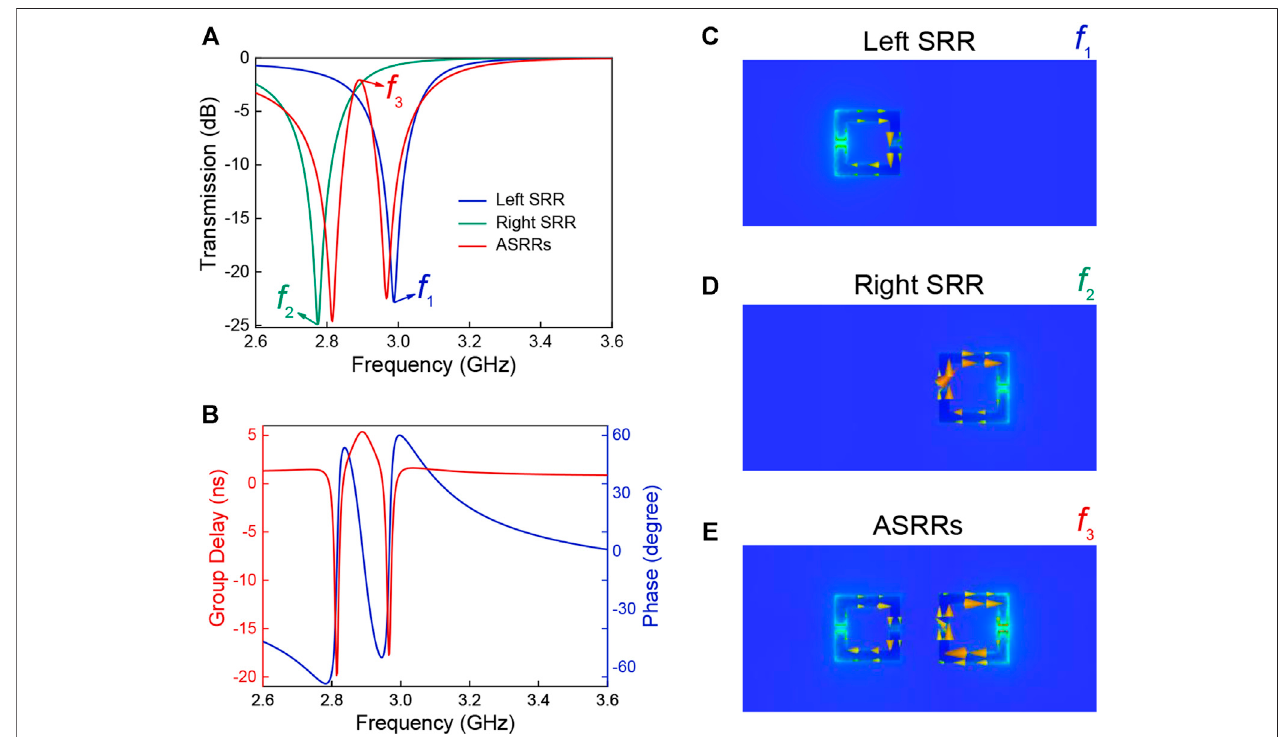
FIGURE 2 | (A) Calculated transmission spectra of the left SRR only (blue curve), right SRR only (green curve), and the asymmetric SRR pair (red curve). (B) Calculated transmission group delay (red curve) and phase (blue curve) of the metasurface. (C – E) Instantaneous distributions of the out-of-plane electric fi eld and the inducedsurfacecurrentcorrespondingtotheresonantfrequenciesat f 1 , f 2 ,and f 3 insection (A) .Arrowsindicatetheinstantaneousdirectionsofthecurrent fl ow.Allthese results are obtained when the capacitance of varactor diodes is 2.63